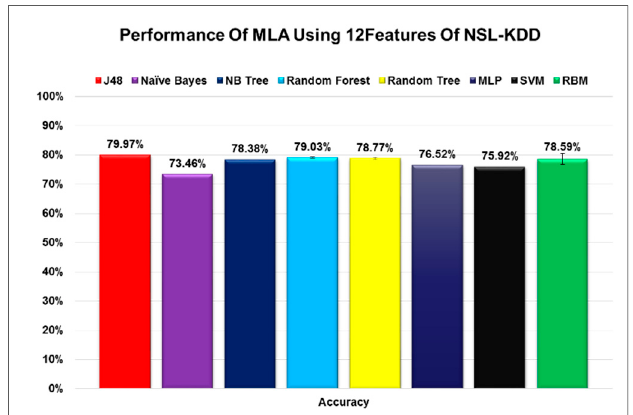
Figure 4. The performance of RBM in comparison to seven different algorithms when using 22 features.